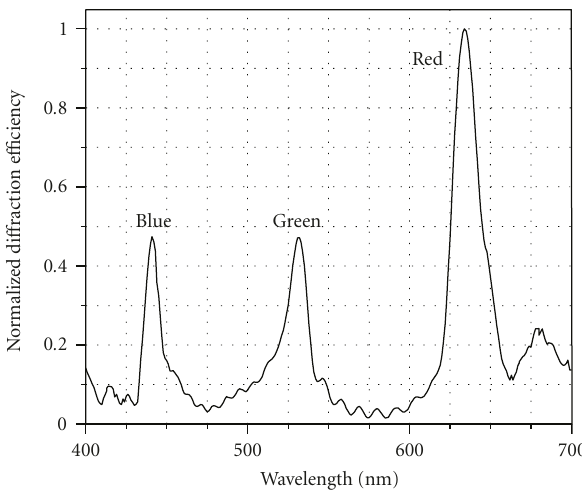
Figure 4: Spectral dependence of di ff raction e ffi ciency of bleached reflection holograms for multiple RGB recording of collimated beams in visible spectral